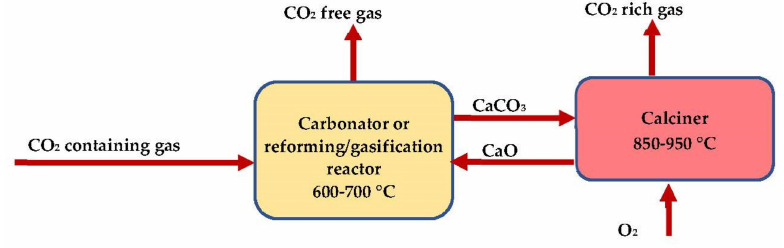
Figure 5. Calcium looping